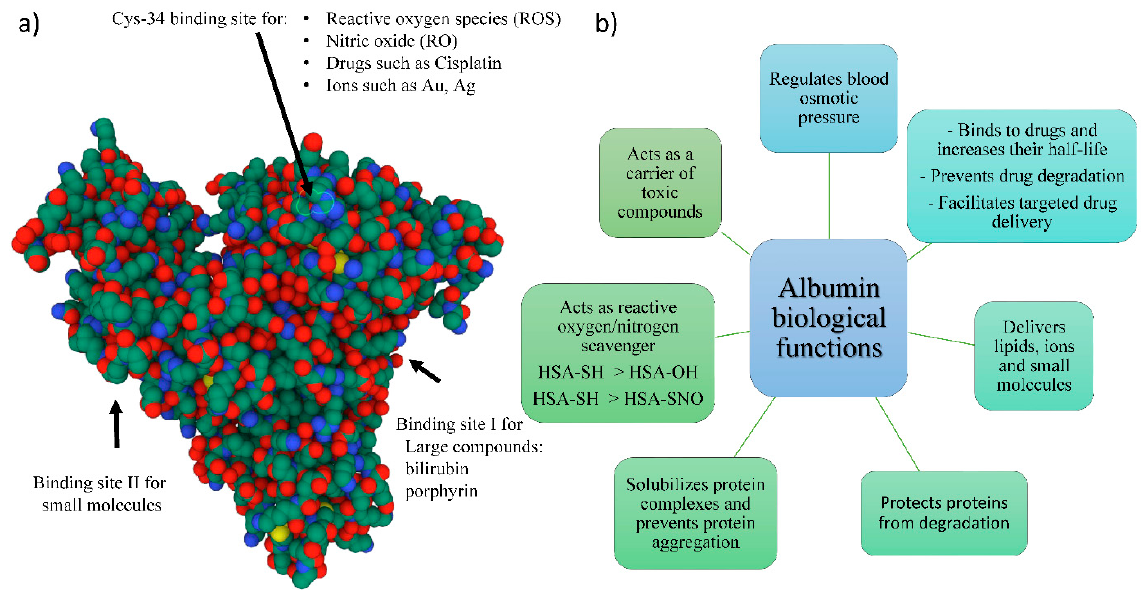
Figure 1. Albumin structure and functions. ( a ) Schematic presentation of different binding sites of albumin protein (3D structure is adapted from RCSB Protein Data Bank). Atoms are represented as spheres with conventional color coding: carbon (green), nitrogen (blue), oxygen (red), and sulfur (yellow). ( b ) Diverse biological functions of albumin. HAS-SNO: S -Nitrosylated Human Serum Albumin.